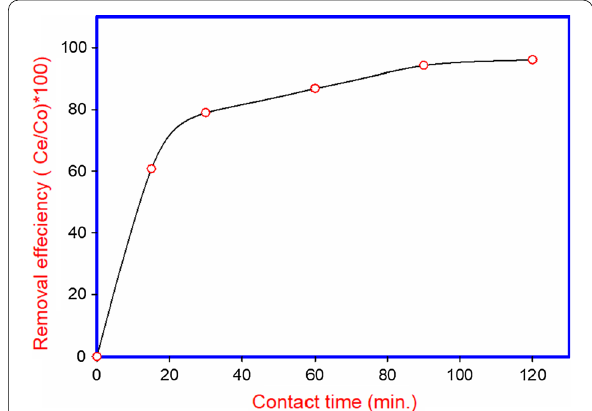
Fig. 5 Effect of pH on the removal efficiencies of M.O, T.B and C.V